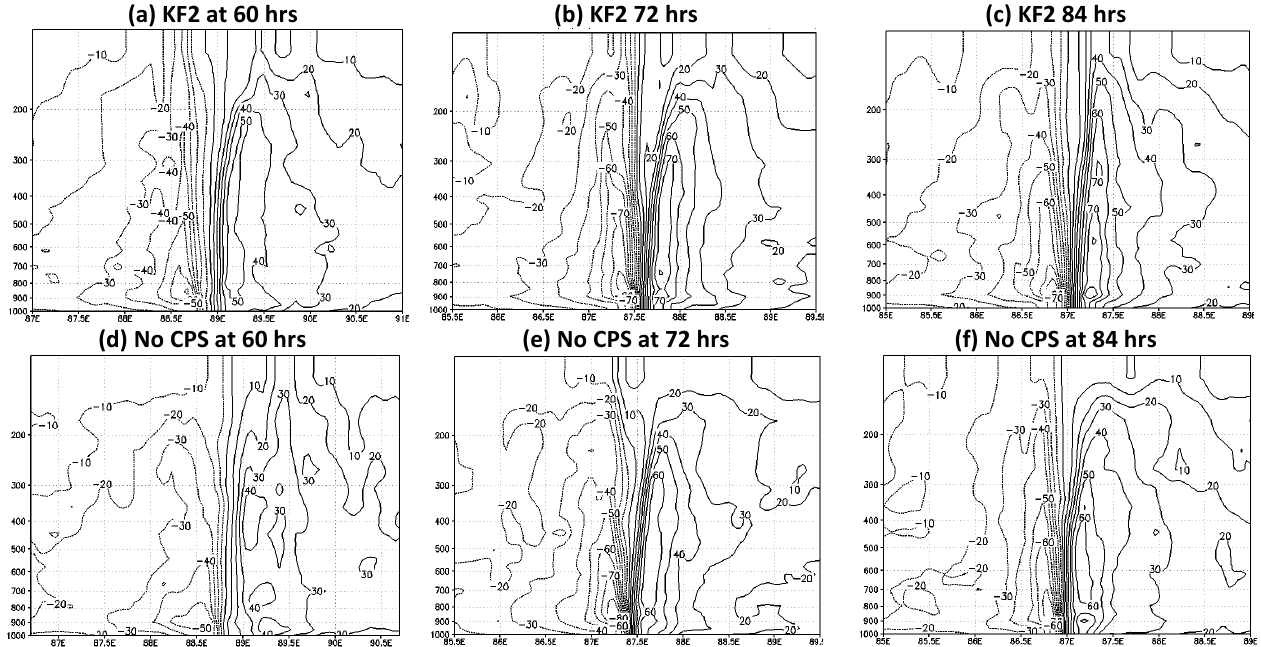
Fig. 10. Vertical cross section (passing through storm centre) of the tangential wind (ms − 1 ) for (a) – (c) KF2 as CPS and (d) – (f) without any CPS in D3 at 60 (00:00UTC of 28), 72 (12:00UTC of 28) and 84 (00:00UTC of 29 October 1999)h of